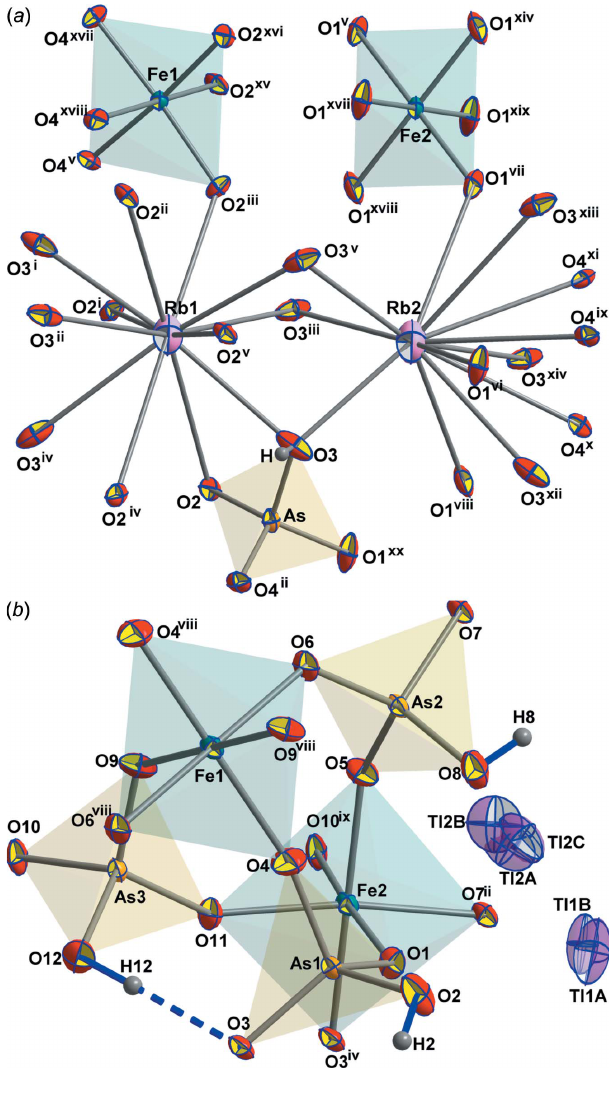
Figure 4 The principal building units of ( a ) RbFe(HAsO 4 ) 2 and ( b ) TlFe(HAsO 4 ) 2 shown as displacement ellipsoids at the 70% probability level. Symmetry